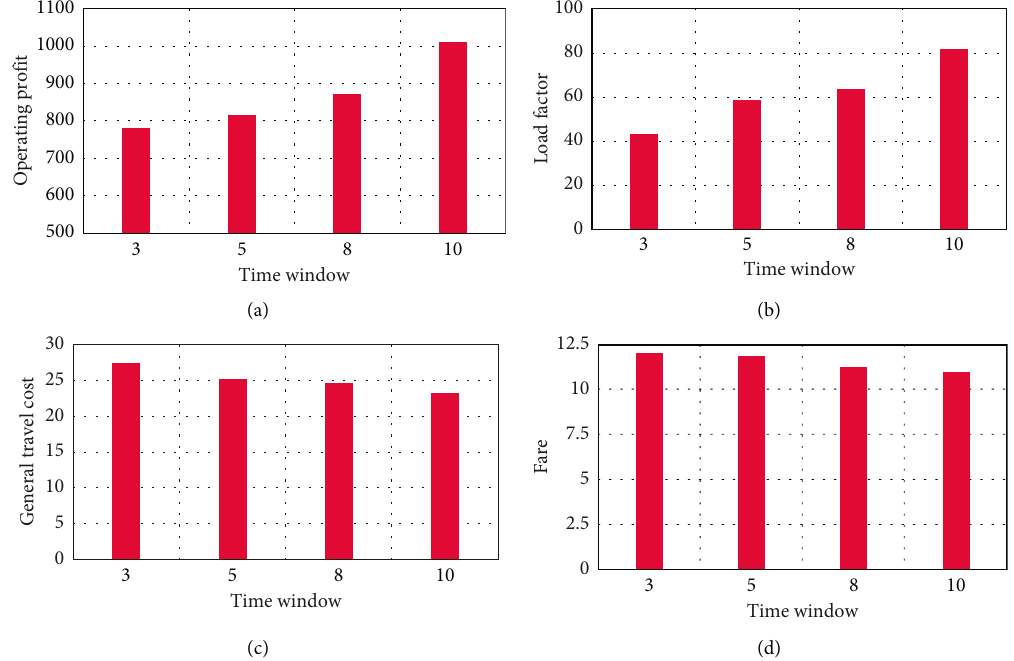
Figure 9: Sensitivity analysis of the time window. (a) Operating profit. (b) Load factor. (c) General travel cost. (d) Fare.